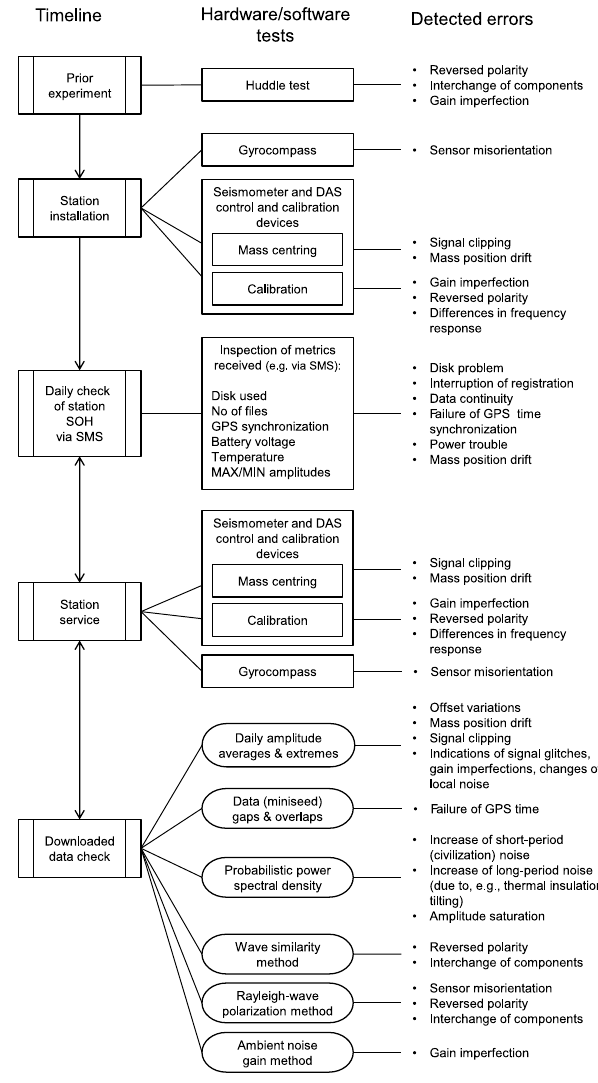
Figure 13. Optimal workflow of temporary station control and data quality checks to assure the archiving of the high-quality data. The hardware and software procedures are shown with rectangular and rounded boxes,